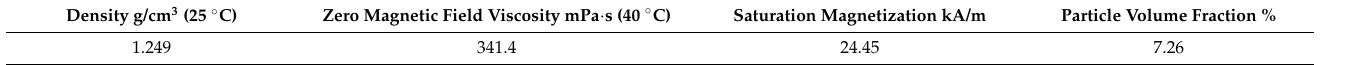
Table 2. Physical parameters of L-AN32-based